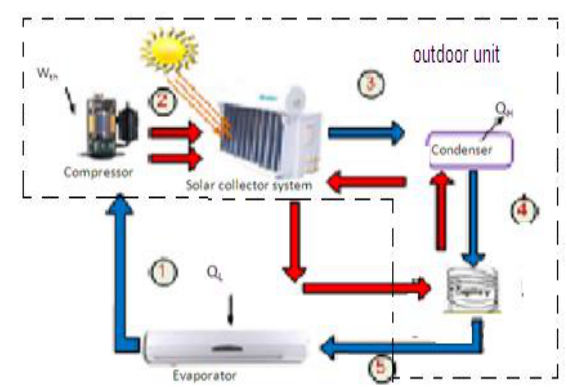
Fig.4: p-h diagram of hybrid compression [12].